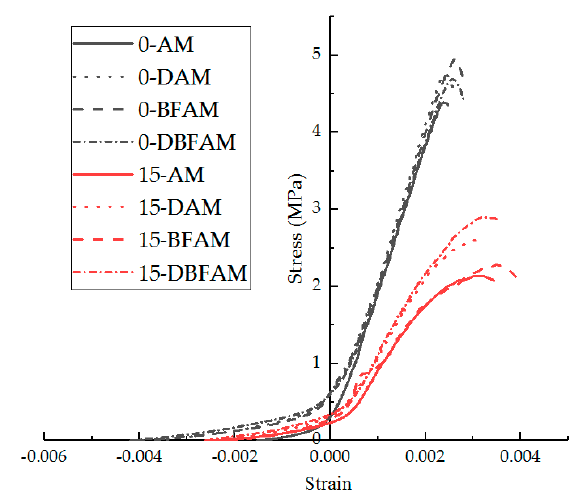
Figure 13. Stress–strain curve of IDT test before and after F–T cycles.